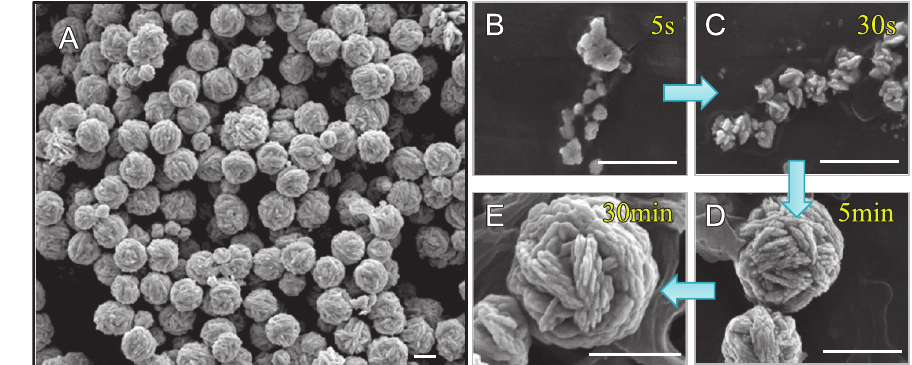
Fig. 7 SEM images of the silver products synthesized in 40 mM glycine solution. A showing the low- magnification SEM image of silver spheres synthesized at 30 minutes, indicating high yield of spherical particles. B showing the silver nanoparticles synthesized at 5 seconds; C showing the silver aggregates synthesized at 30 seconds; D and E showing silver sphere-like particles synthesized at 5 and 30 minutes, respectively. The scale bars represent 1 μm.